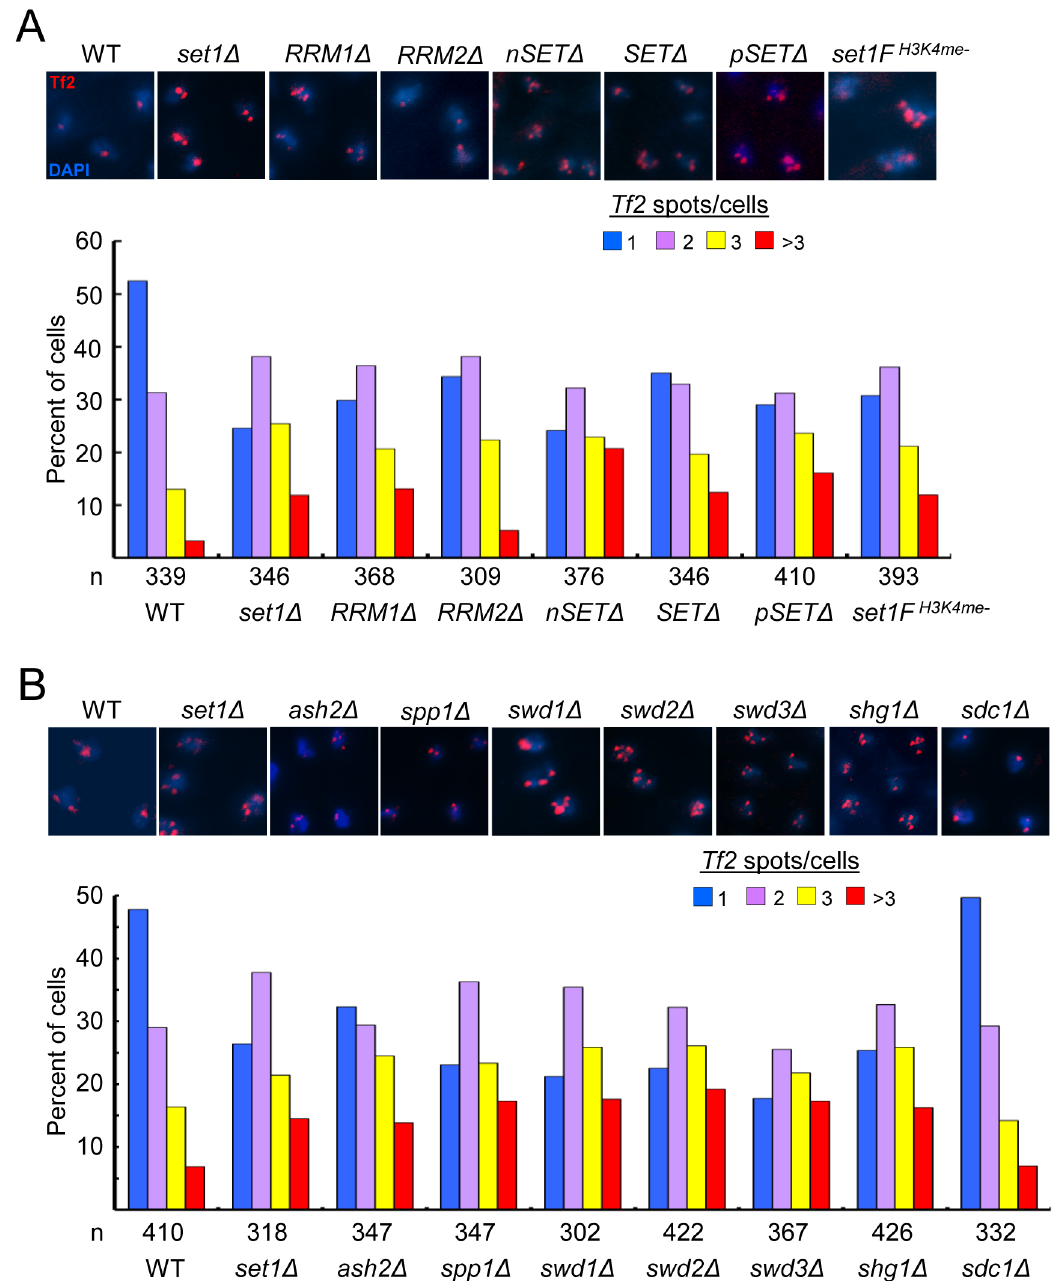
Figure 5. Set1C and H3K4me are required for the integrity of Tf bodies. (A, B) Declustering of Tf2s in (A) set1 mutant with defects in H3K4me and (B) Set1C mutants. Fluorescence in situ hybridization (FISH) analysis was performed using a FISH probe corresponding to the , 3.6 kb coding region of Tf2 elements. Representative FISH images from indicated strains (top panels). Quantitative FISH analysis of observed Tf2 foci/cell in indicated strains (bar graph; bottom panels). Number of cells analyzed per strain ( n ). Except for sdc1 D , Tf2 declustering in all mutant strains compared to WT was significant ( p , 0.005, chi-square test).